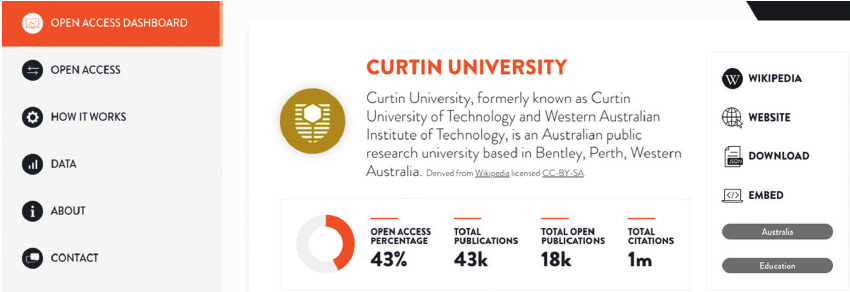
Fig. 6: A summary of research performance for Curtin University, 2000–2021. Data sources: Crossref, Unpaywall, Microsoft Academic. Analysis and Image: Curtin Open Knowledge